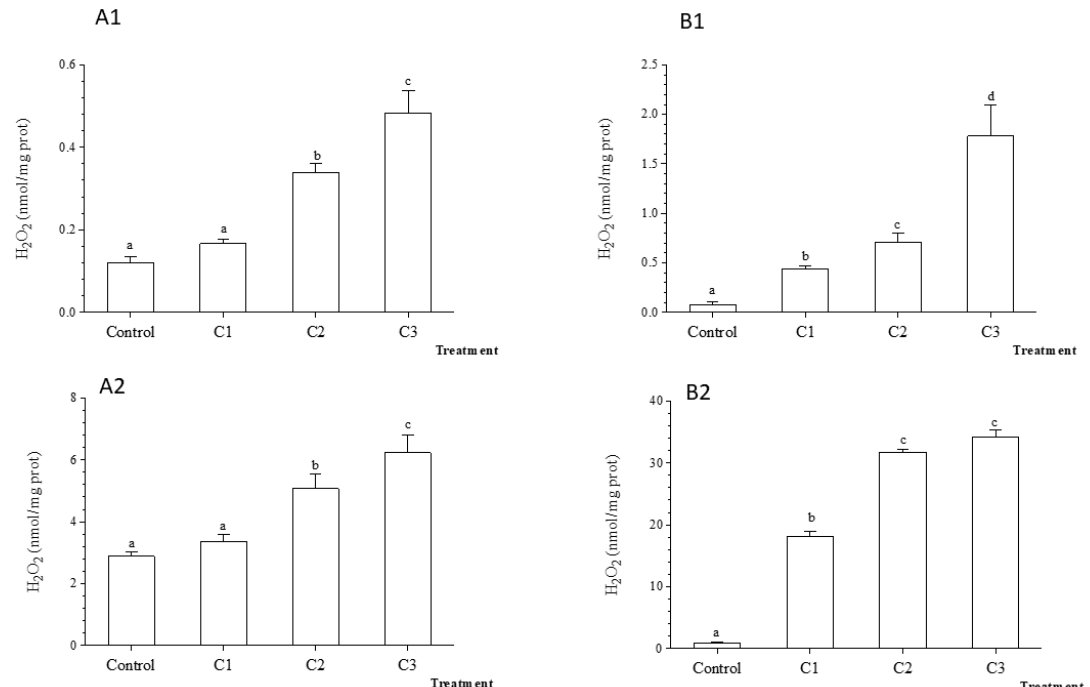
Figure 6. Average hydrogen peroxide (H 2 O 2 ) ( ± standard deviation) in the freshwater mussel Unio ravoiseri after exposure to Control and three concentrations of Titanium dioxide nanoparticles during 48 h and 7 days in gills, respectively ( A1 ) and ( A2 ), and in digestive gland ( B1 ) and ( B2 ). Bars represent the group means ± SE; a, b, c, d: data not sharing a common letter are significantly different using Tukey’s HSD test ( p < 0.05).